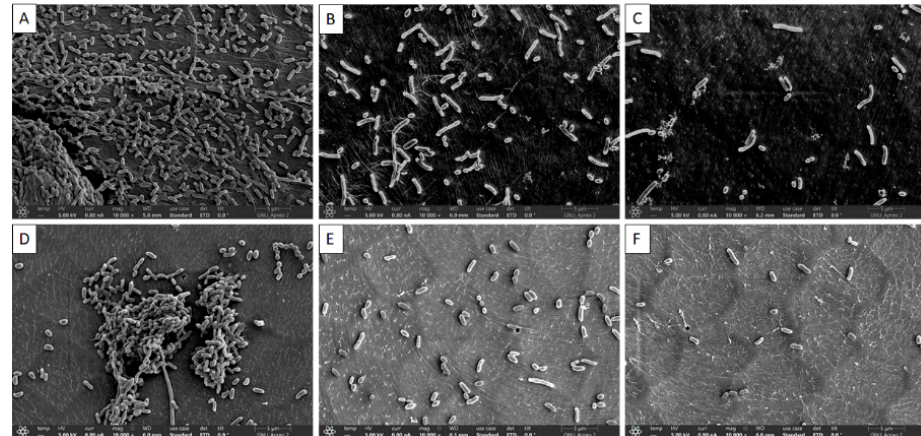
Figure 5. Representative scanning electron micrographs of Vibrio parahaemolyticus biofilms for- mation in the presence of sub-MICs of quercetin on the crab surfaces: ( A ) Control (0% quercetin); ( B ) 1/4 MIC; ( C ) 1/2 MIC and shrimp surfaces; ( D ) Control (0% quercetin); ( E ) 1/4 MIC; ( F ) 1/2 MIC.